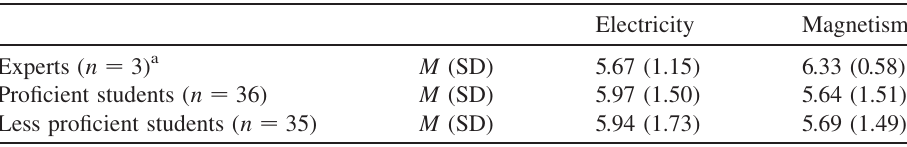
TABLE V. Average numbers of stacks for all